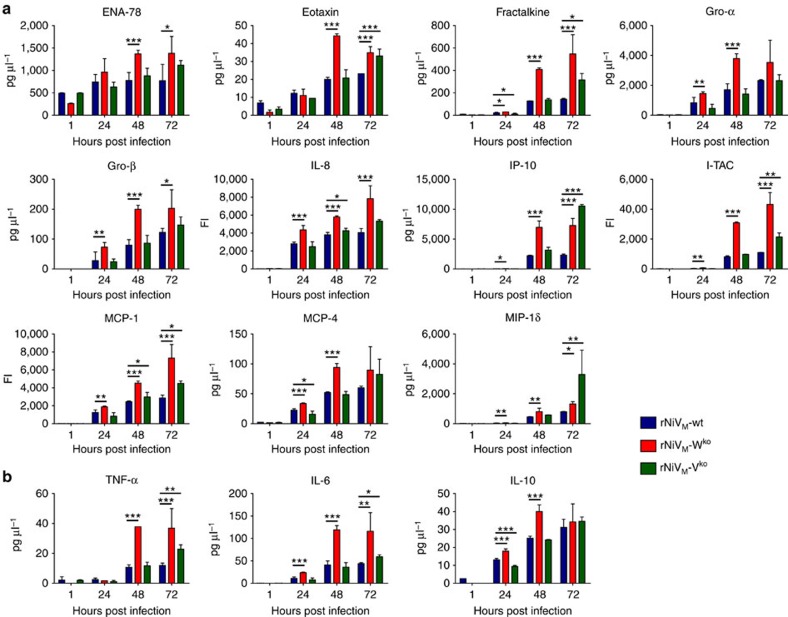
Selected chemokine/cytokine levels in supernatants of infected HPMECs.Inflammatory chemokine levels (a) and innate immune cytokine levels (b) of HPMECs infected with rNiVM-wt (blue), rNiVM-Wko (red) or rNiVM-Vko (green). Error bars show s.d. ANOVA with Dunnett's multiple comparison test; N=4. *P value<0.05; **P value<0.01; ***P value<0.001 compared with rNiVM-wt, FI, fluorescence intensity.